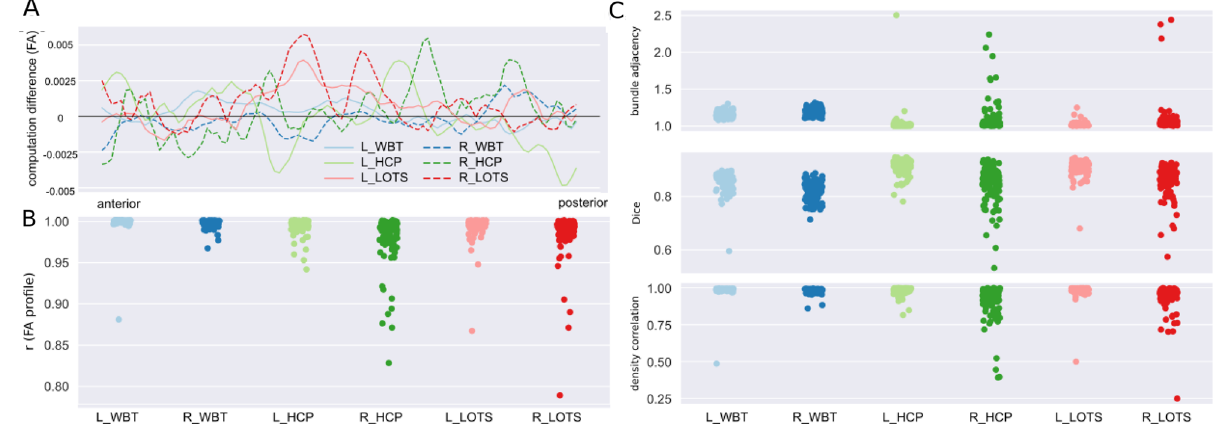
Figure 3. Evaluation of computational reproducibility for arcuate fasciculus tracking across three procedures. ( A ) Per procedure/hemisphere across-subject mean FA tract-profile differences between the first and the second computations. ( B ) Strip plots showing the distribution of correlation coefficients between all possible pairs computed for each tract and each subject. Each dot represents the correlation coefficient for a specific computation pair for one participant. ( C ) Macrostructural agreement indices distribution: bundle adjacency (top), Dice coefficient (middle), and density correlation (bottom) between the two separate computations for each tract and each